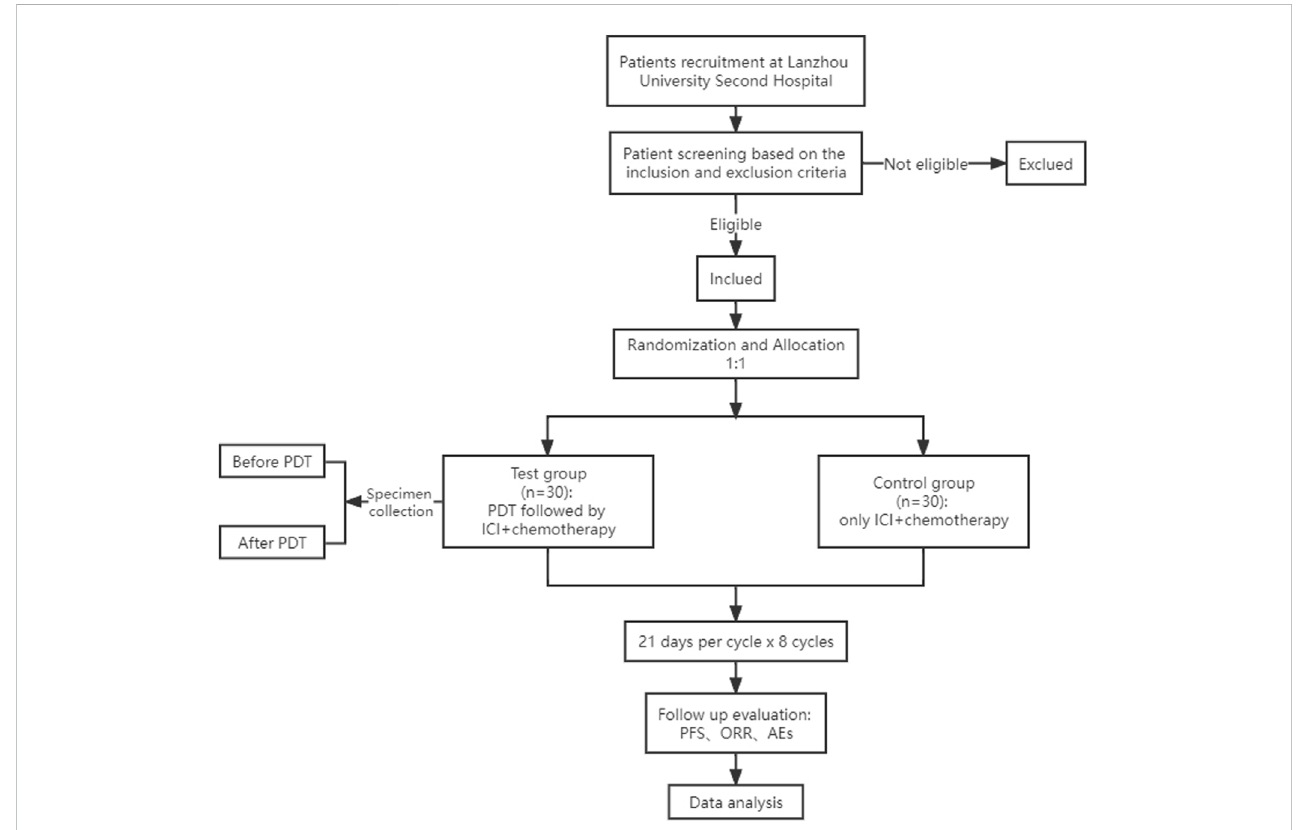
FIGURE 1 Flowchart of the trial. PDT, photodynamic therapy; ICI, immune checkpoint inhibitor; PFS, progression-free survival; ORR, objective response rate; AEs, adverse events.